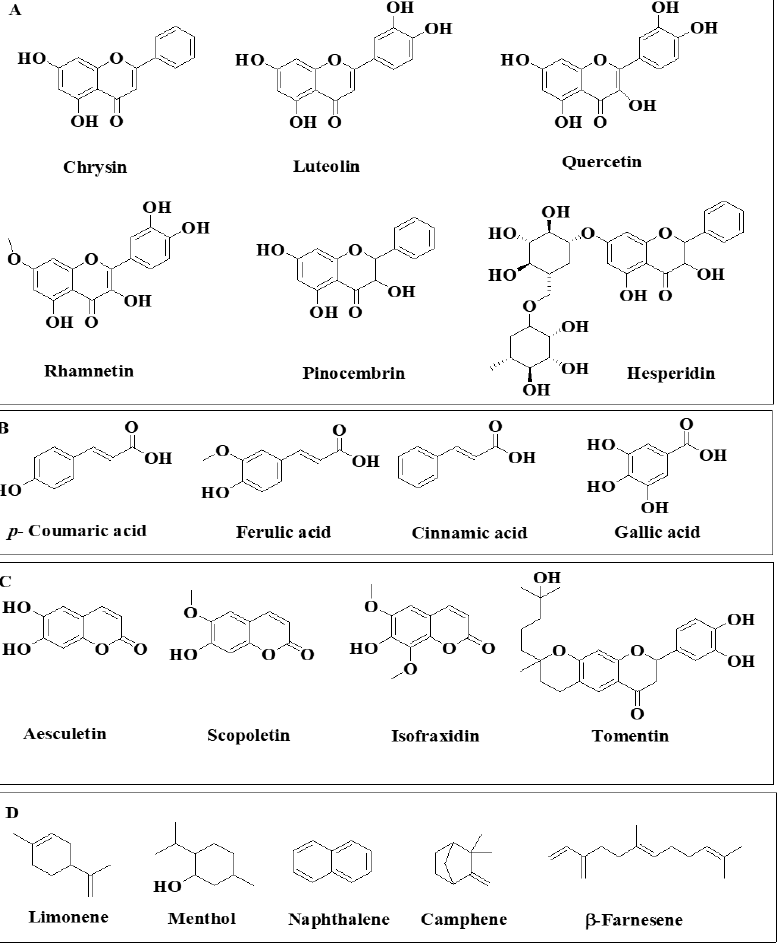
Figure 8. The fundamental classes of bioactive compounds present in Artemisia : ( A ) flavonoids; ( B ) phenolic acids; ( C ) coumarin; ( D ) terpene.